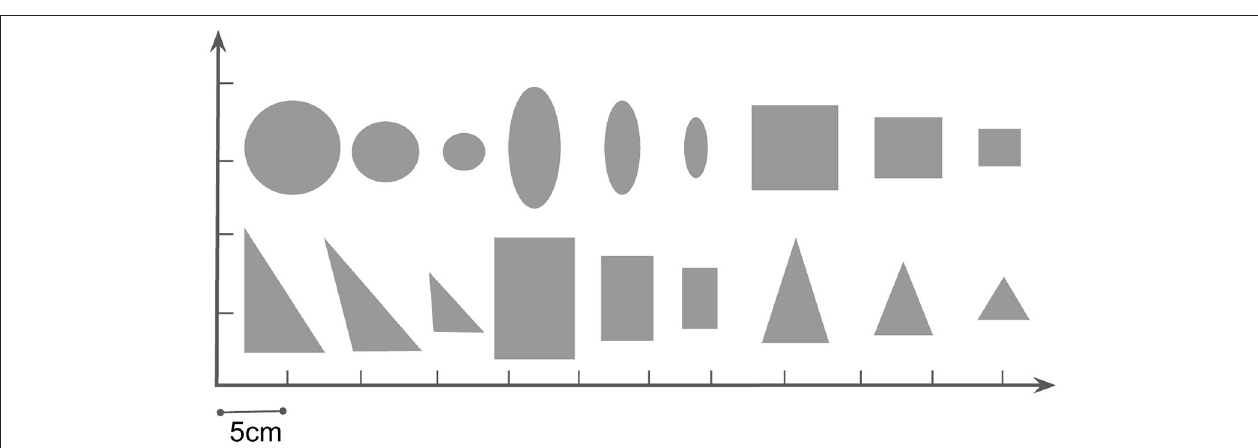
FIGURE 5 | We use 18 different objects in our pushing task, all of them of 2cm height. The physical parameters which can affect the dynamics are randomized from a range in Table 2 with automatic domain randomization (ADR) during training.